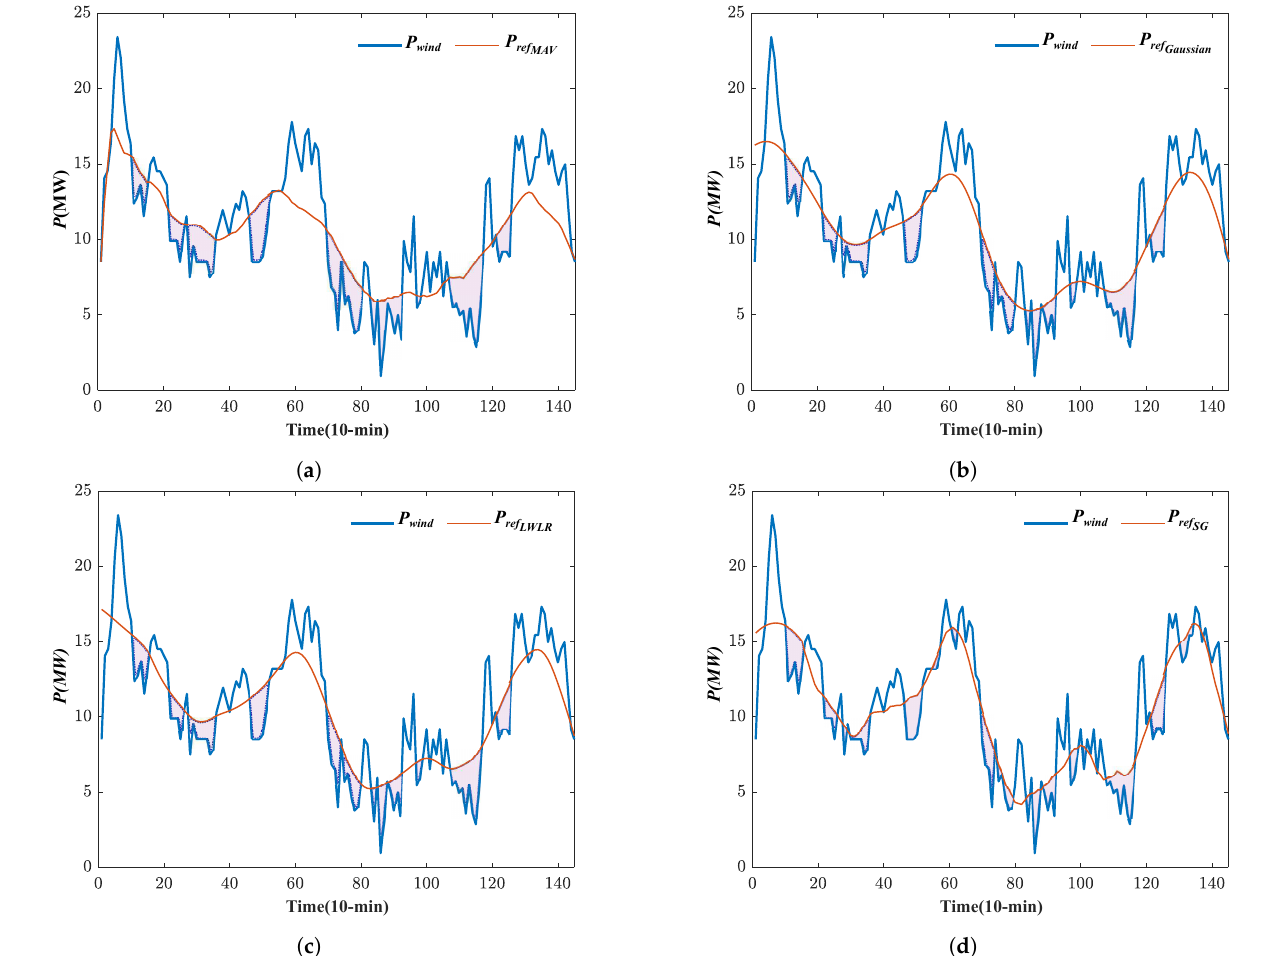
Figure 8. One day sample for shortages of P wind to fulfill the P ref : ( a ) MAV; ( b ) Gaussian; ( c ) LWLR; ( d ) SG. Running the suggested method in NIA produced several PV plant and BESS setups with COE and LPSP, as illustrated in Figure 9. As the sizing of BESS is meant to minimize oversizing by considering just the minimal yearly negative accumulative net energy, the BESS size dropped with each increase in S for each smoothing approach, and finally the size was fixed. The minimum CE values for the whole year are 0.72609 (for LWLR), 0.6680 (for MAV), 0.57942 (for Gaussian), and 0.41753 MWh (for SG), as shown in Figure 10. The capacity of the BESS began at 18.74 MWh for S = 0, and then reached the minimum value of 0.8350 MWh for S = 0.04 (with the MAV). In addition, the minimum COE was 0.0229 EUR/kWh, with 10.716 MW for the PV plant sizes. The simulation results also attest to the effect of LWLR, Gaussian, and SG in smoothing the wind power to overcome the negative impact of the memory effect in MAV. Compared to MAV, the optimal sizes of the BESS and PV for LWLR, Gaussian, and SG were attained while S = 0.02. Thus, the optimal COE was 0.0237 EUR/kWh (for LWLR), 0.0203 EUR/kWh (for Gaussian), and 0.0165 EUR/kWh (for SG). However, the COE for LWLR was the highest, due to the size of the BESS, which reached 0.9076 MWh. On the other hand, the BESS for the SG was 0.2024 MWh lower than the BESS size for the Gaussian. The PV size was 5.329 (for LWLR), 5.329 (for Gaussian), and 5.305 MW (for SG). These techniques yielded similar PV size values, in contrast with MAV, which yielded a value of 10.716 MW. Table 2 shows an overview of the best